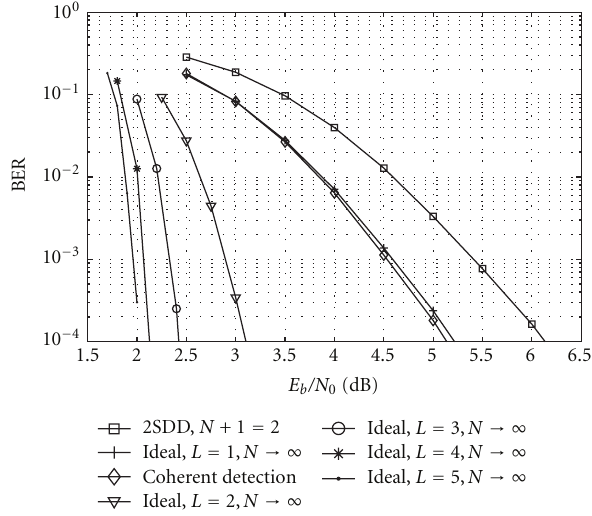
Figure 9: Bit error performance of the Peleg method for trellis length N → ∞ and up to L = 5 iterations.